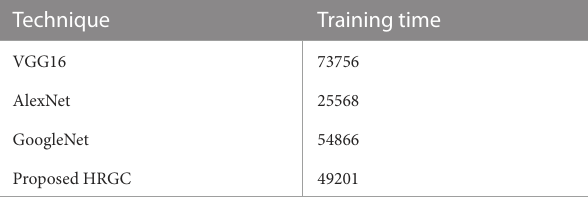
TABLE3 Performancecomparisonofaccuracy,precision,recall,and F1-measure(Latif et al.,2022). Technique